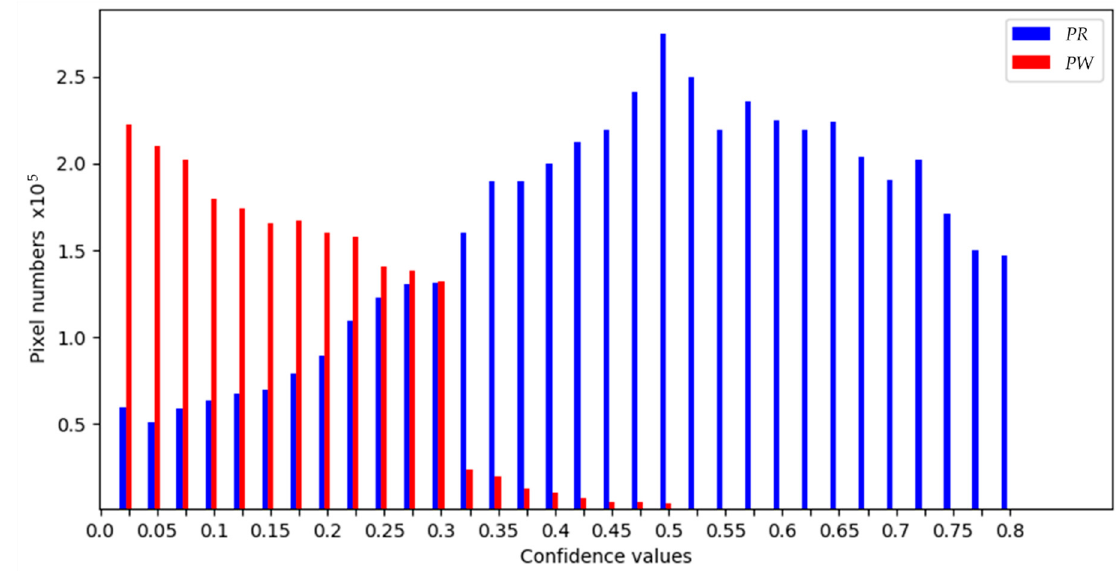
Figure 5. An example of a histogram.